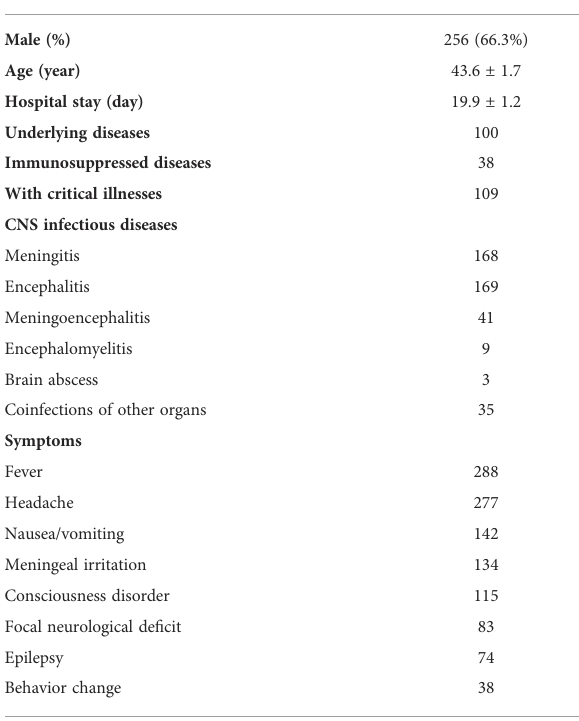
TABLE 1 The baseline of the patients enrolled in this